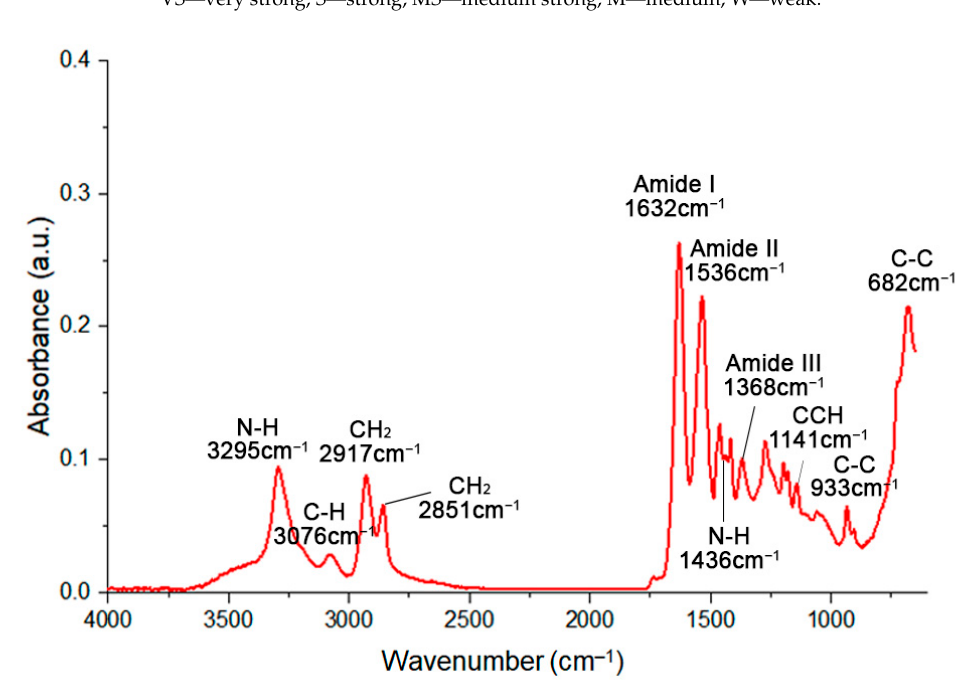
Figure 11. FTIR band assignment of PA66 microfibres unexposed to degradation mechanism. The band ≈ 1630 cm − 1 may correspond to the carbonyl group from amide groups (NH-C=O) and the reference peak selected was the most intense band from the CH 2 stretching. The reference blank was selected assuming that CH groups may undergo less oxidation and may remain constant [76].